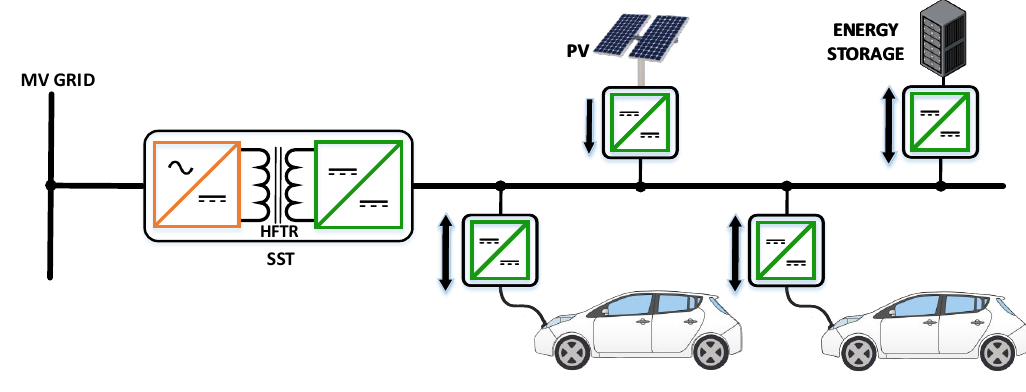
Figure 8. EV XFC stations based on SST technology.